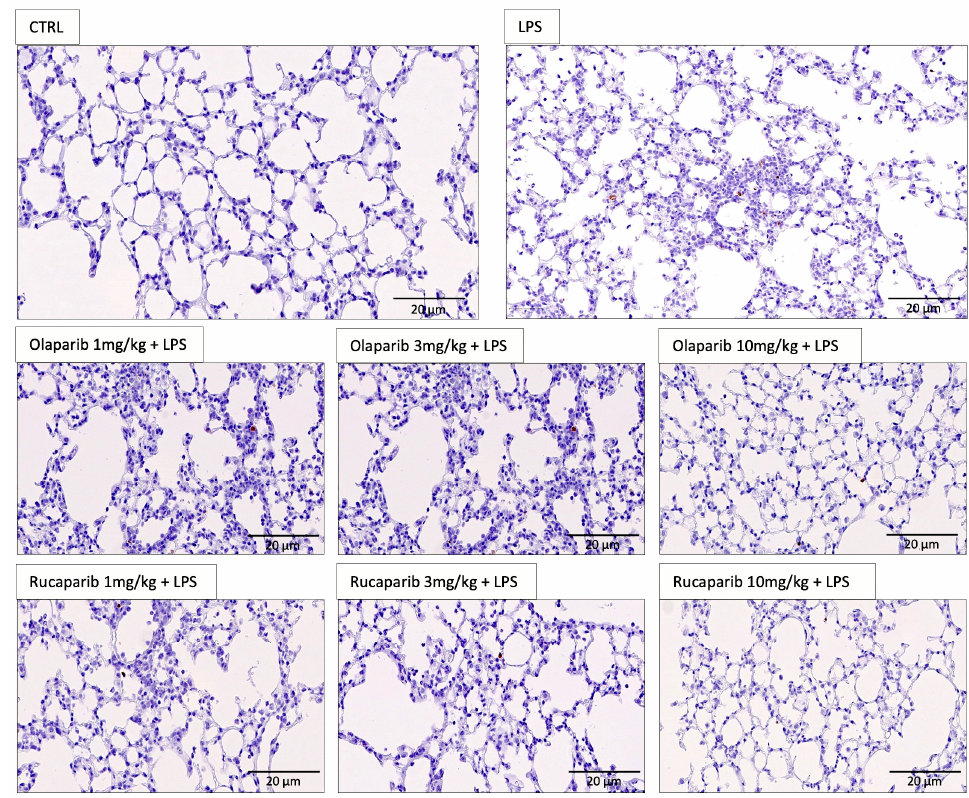
Figure 13. Effect of olaparib and rucaparib on DNA damage in the lung in a murine model of ALI. Representative histological images are shown. Note the increased number of TUNEL-positive cells (brown dots) after LPS and the fewer number of TUNEL-positive cells in the groups treated with the PARP inhibitors. Data were quantified and are expressed in numerical units in Figure 14.